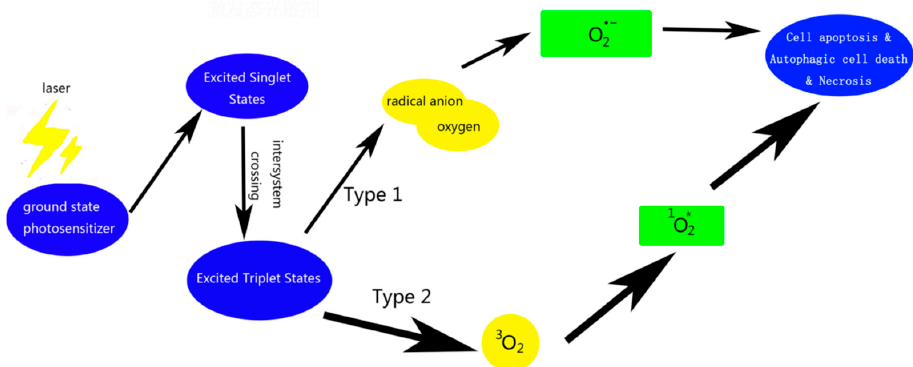
Figure 7. Activation of PS and generation of ROS involved in PDT. Reproduced from Kou et al. [66],